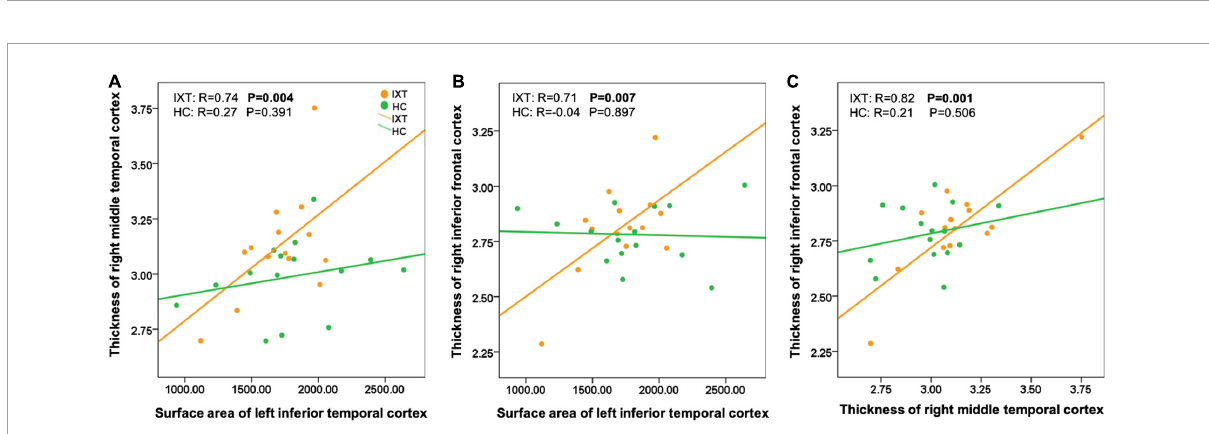
FIGURE3 Scatter plots showing structural covariance differences between patient with IXT and HC (A–C) . IXT, intermittent exotropia; HC, healthy